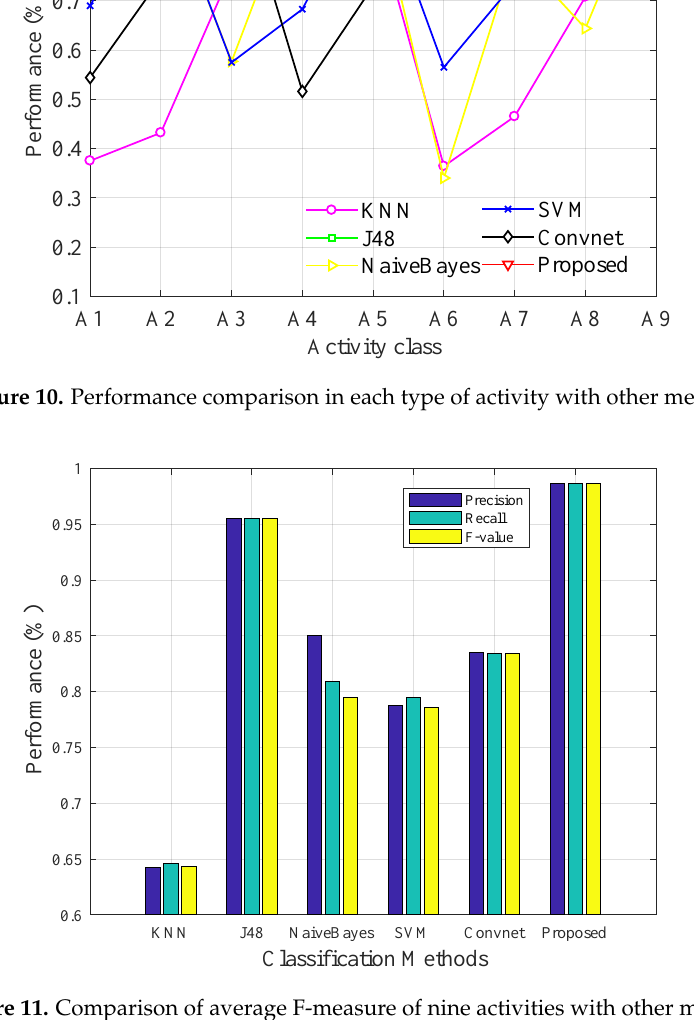
Figure 11. Comparison of average F-measure of nine activities with other